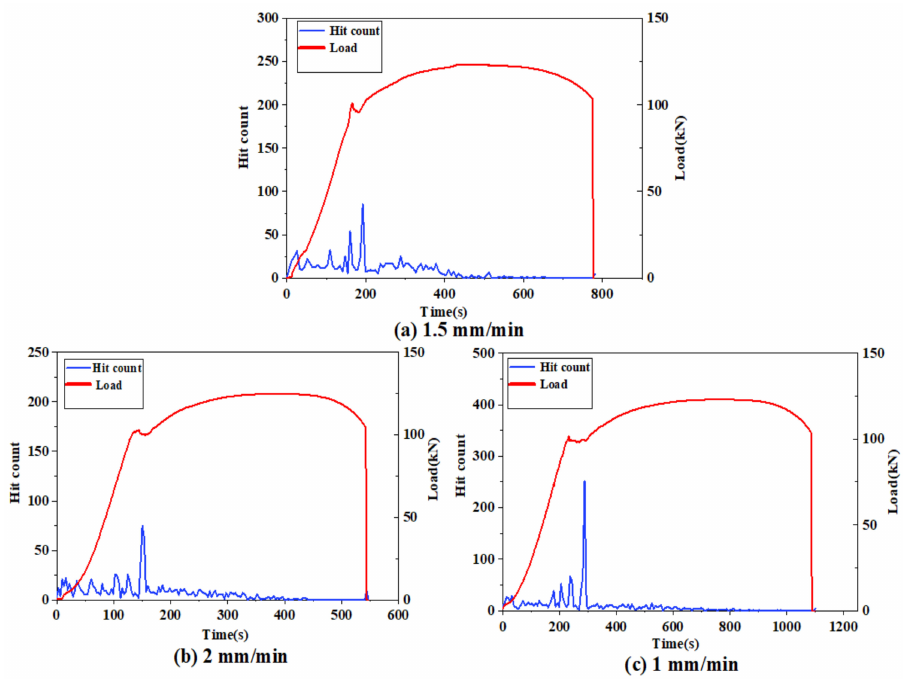
Figure 15. ( a ): variation of hit counts with stretching force for a rate of 1.5 mm/min; ( b ): variation of hit counts with stretching force for a rate of 2 mm/min; ( c ): variation of hit counts with stretching force for a rate of 1